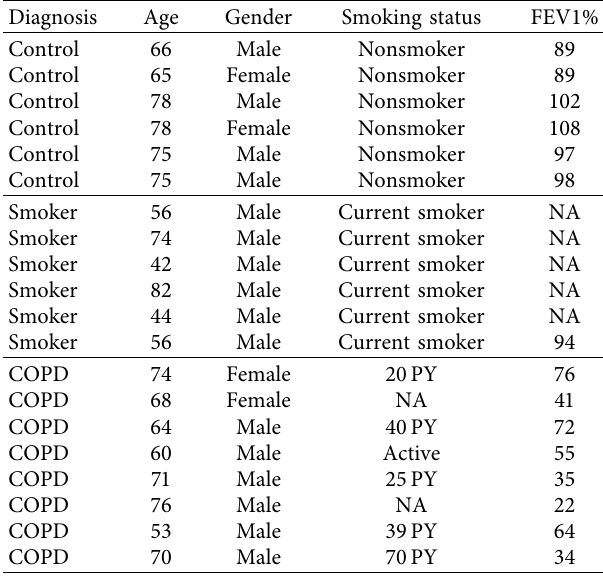
Table 1: Clinical parameters of primary cell